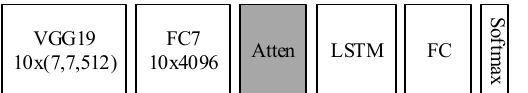
Figure 7. Our proposed architecture and the compared network architecture.